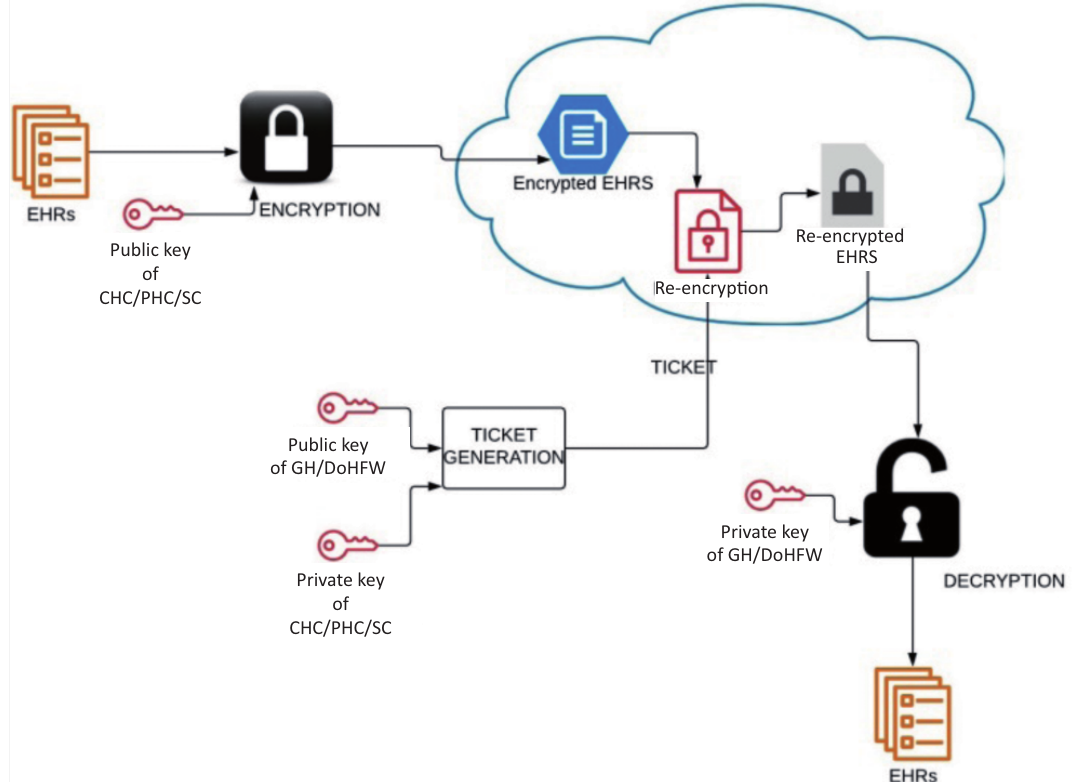
Fig. 4. Secure EHR sharing between CHCs/PHCs/SCs and